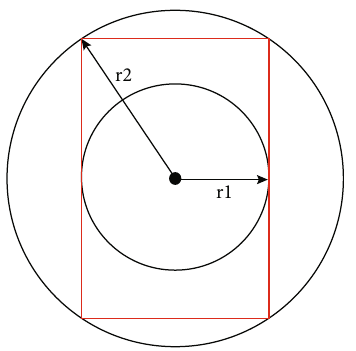
Figure 4: Tracking the smallest outer circumscribed rectangle and the inside and outside circles.